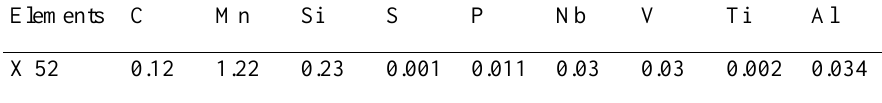
Table 1. Chemical composition of X52 steel